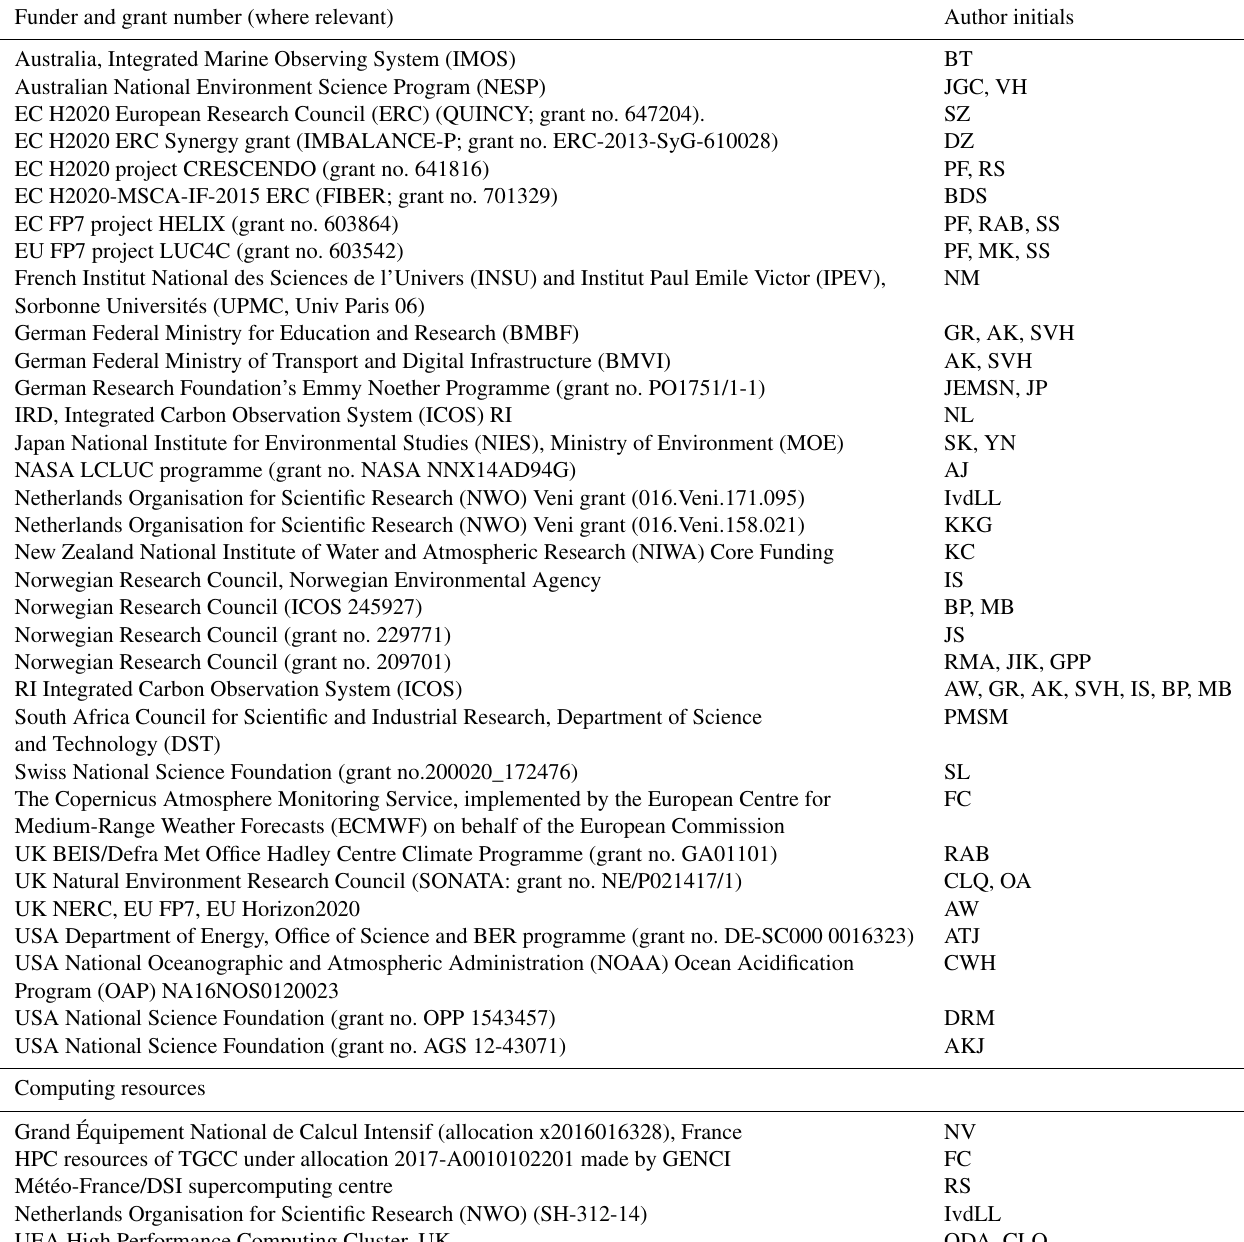
Table A5. Funding supporting the production of the various components of the global carbon budget in addition to the authors’ supporting institutions (see also